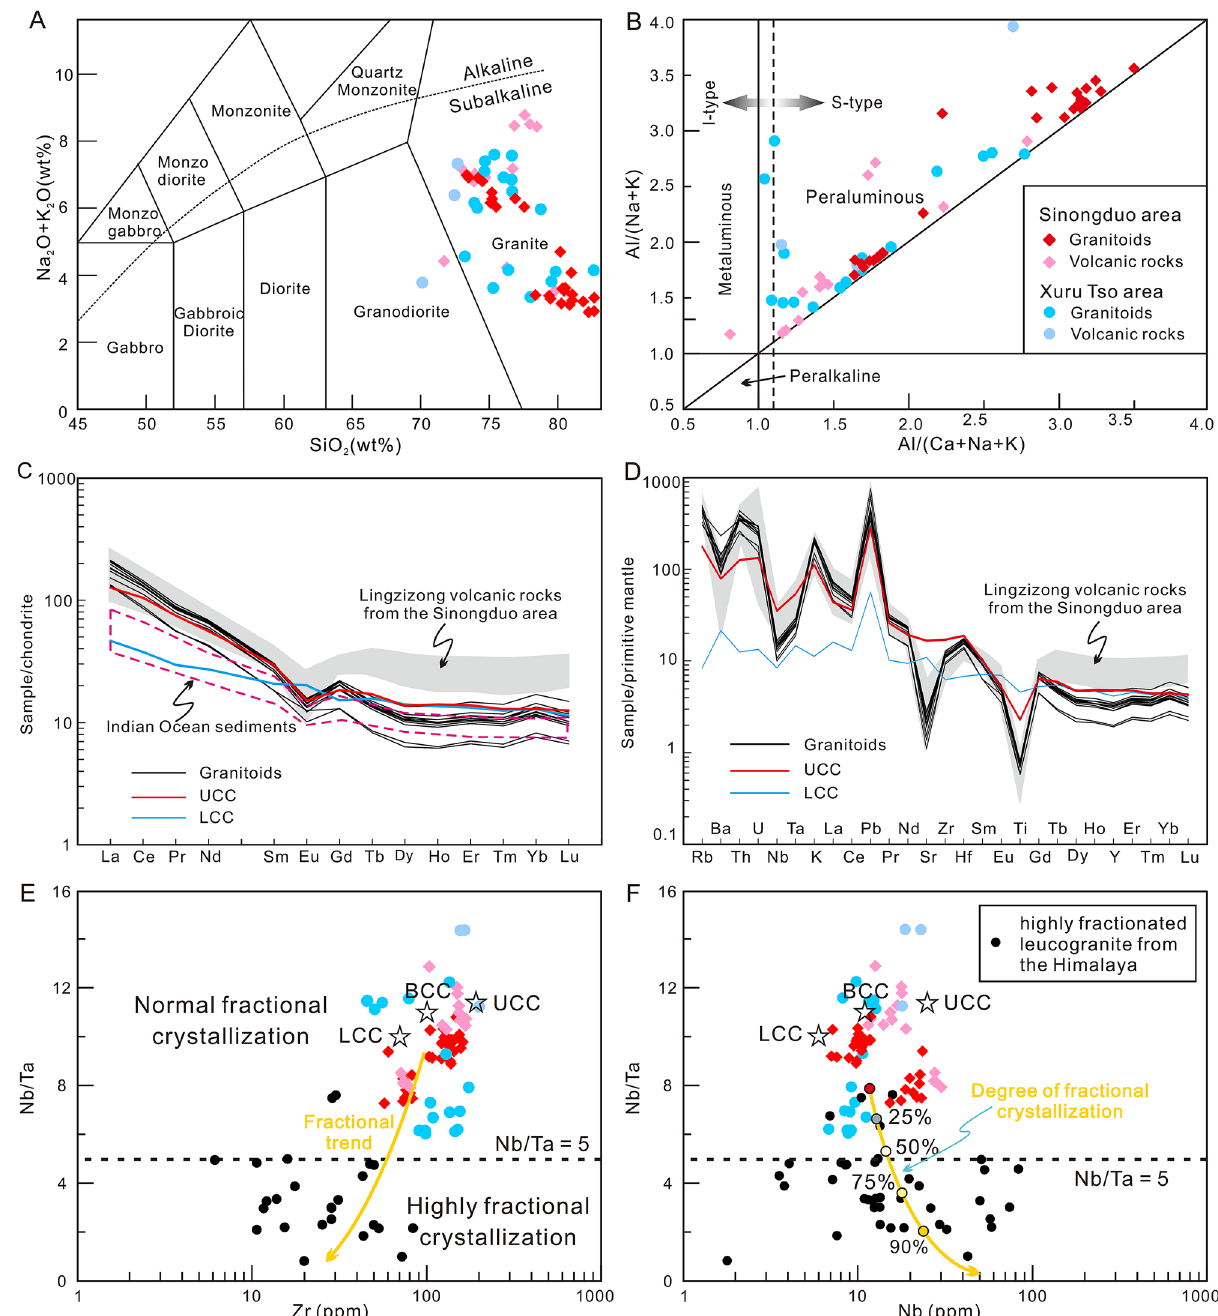
Figure 5. Geochemical characteristics of Paleocene S-type granitic rocks from the southern Lhasa block. ( A ) Total alkali versus silica (TAS) diagram. ( B ) A/NK versus A/CNK classification diagram. ( C ) Chondrite- normalized REE patterns and ( D ) primitive mantle-normalized trace element patterns for Paleocene granitoids from the Sinongduo area. ( E ) Nb/Ta versus Zr and ( F ) Nb/Ta versus Nb diagrams 25 . Chondrite and primitive mantle data are from Sun and McDonough 26 . Data for the UCC, BCC and LCC are from Taylor and McLennan 27 . Data for the Himalayan highly fractionated leucogranite are from Liu et al. 28 , and Lin et al. 29 . Data for the Xuru Tso granitoids and volcanic rocks are from Lee et al. 9 , and Gao et al. 10 . Other data for the Sinongduo granitoids and volcanic rocks are from Yang 11 , Zhou et al. 12 , and Ding et al. 21